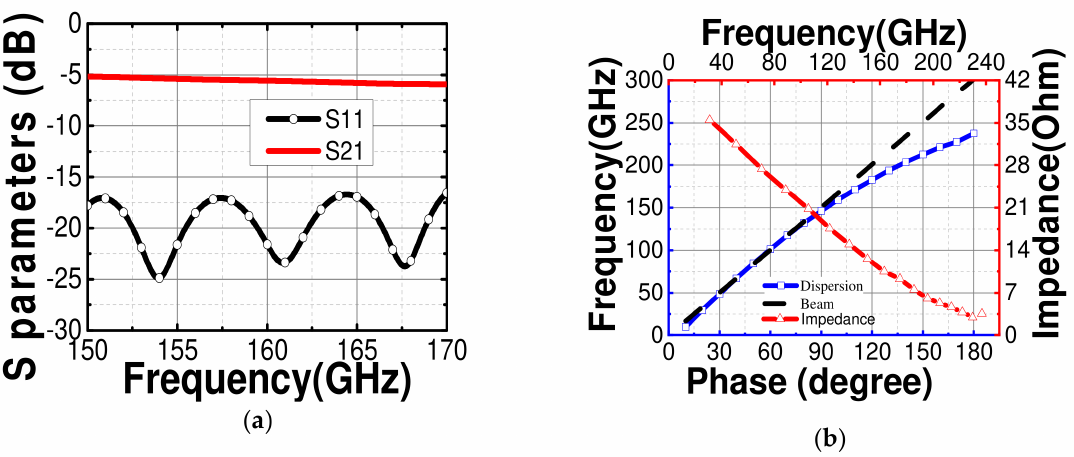
Figure 5. ( a ) Transmission characteristics from 150 to 170 GHz of the designed MML-SWS; ( b ) dispersion characteristic and coupled impedance of the